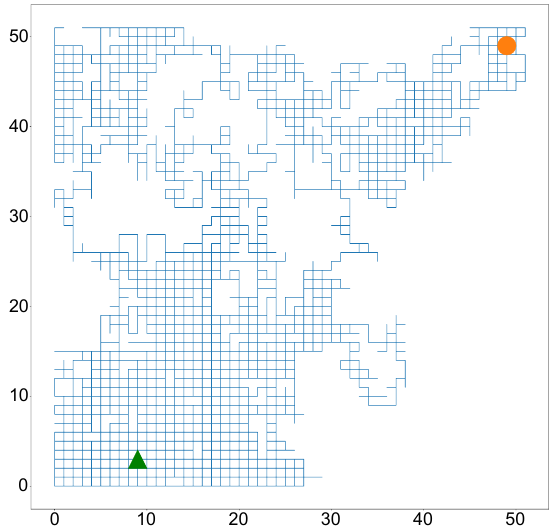
Figure 6. Trajectory used for